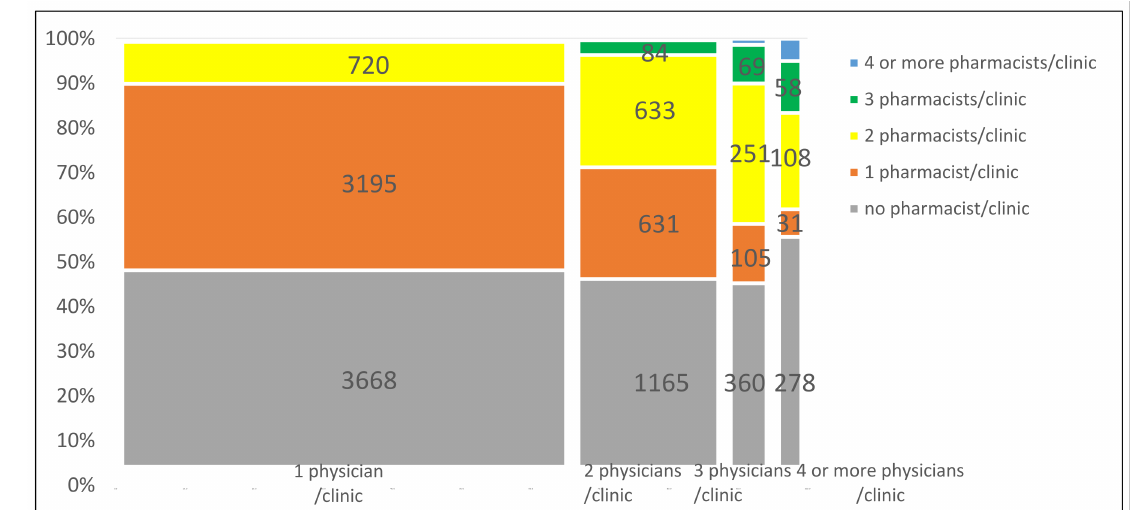
Figure 1. Distribution of the nationwide pharmacist workforce in clinics, stratified by the number of physicians per clinic. The numbers on the graph indicate the number of clinics.